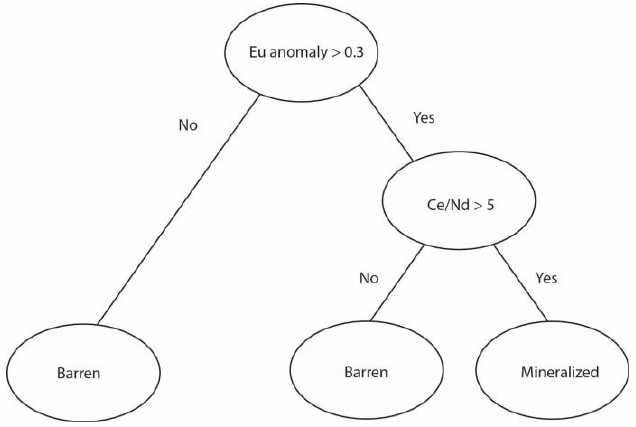
Figure 4. Basic illustration of the decision tree algorithm applied to the zircon geochemistry. Parameters of decision tree and random forest classifier were tuned with Grid search.